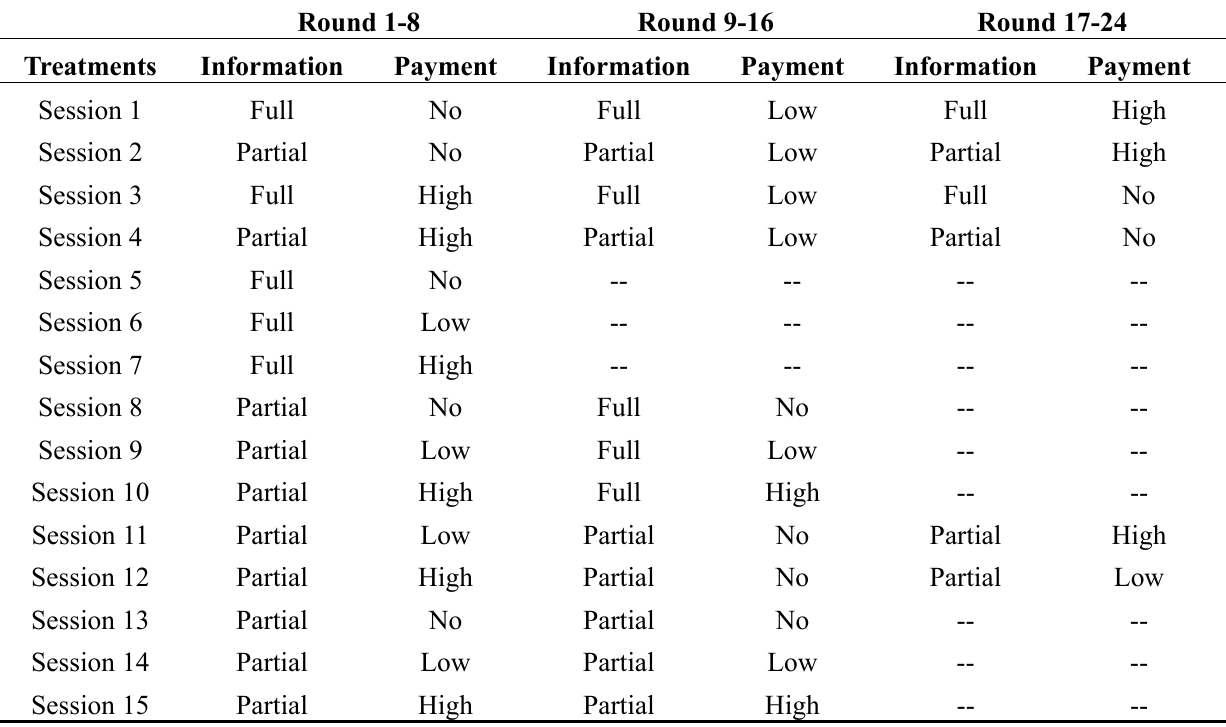
Table 2. Fractional factorial